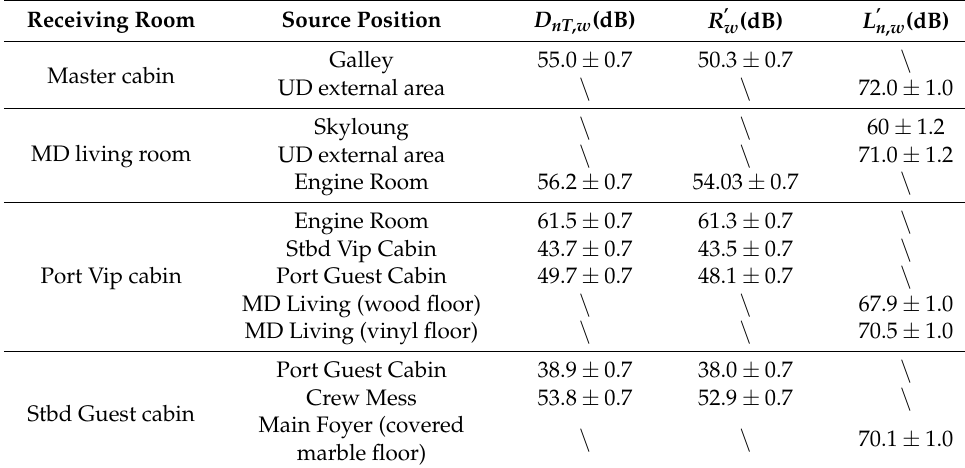
Table 5. Acoustic performance indicators for the different